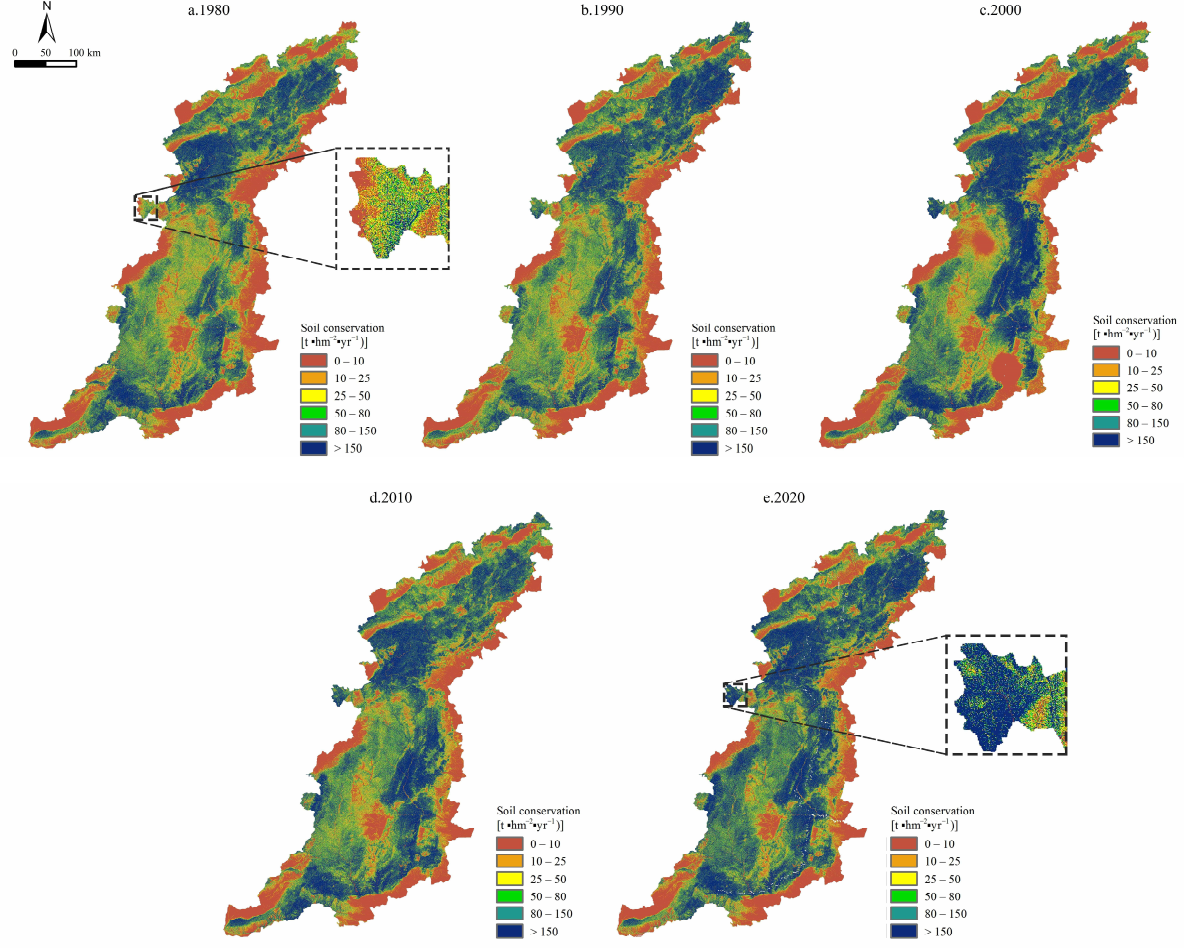
Figure 6. Spatial distribution of SCSs in the Taihang Mountain area from 1980 to 2020.